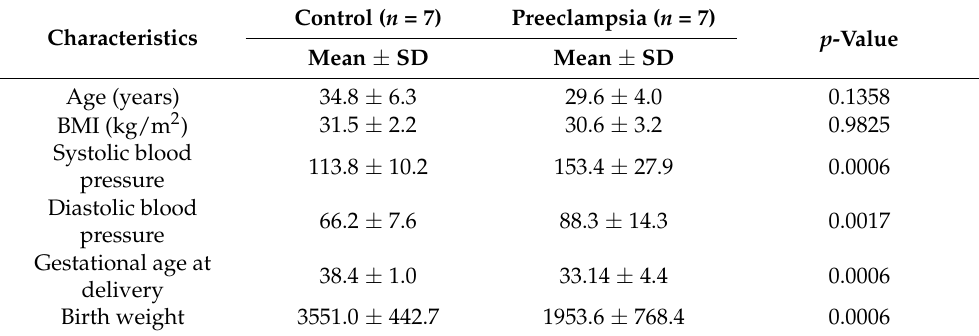
Table 1. Clinical characteristics of the study